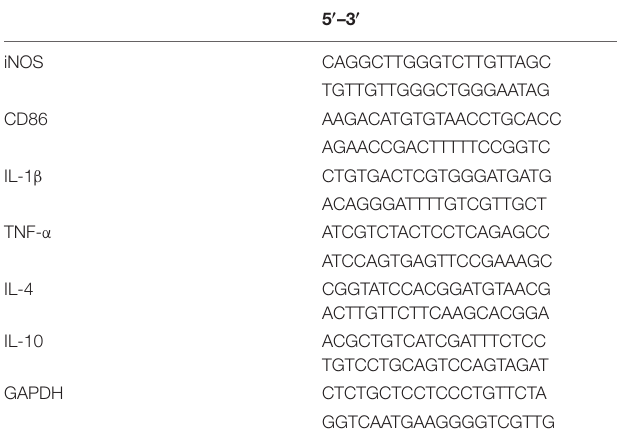
TABLE 1 | Primer sequences used for quantitative reverse transcription PCR